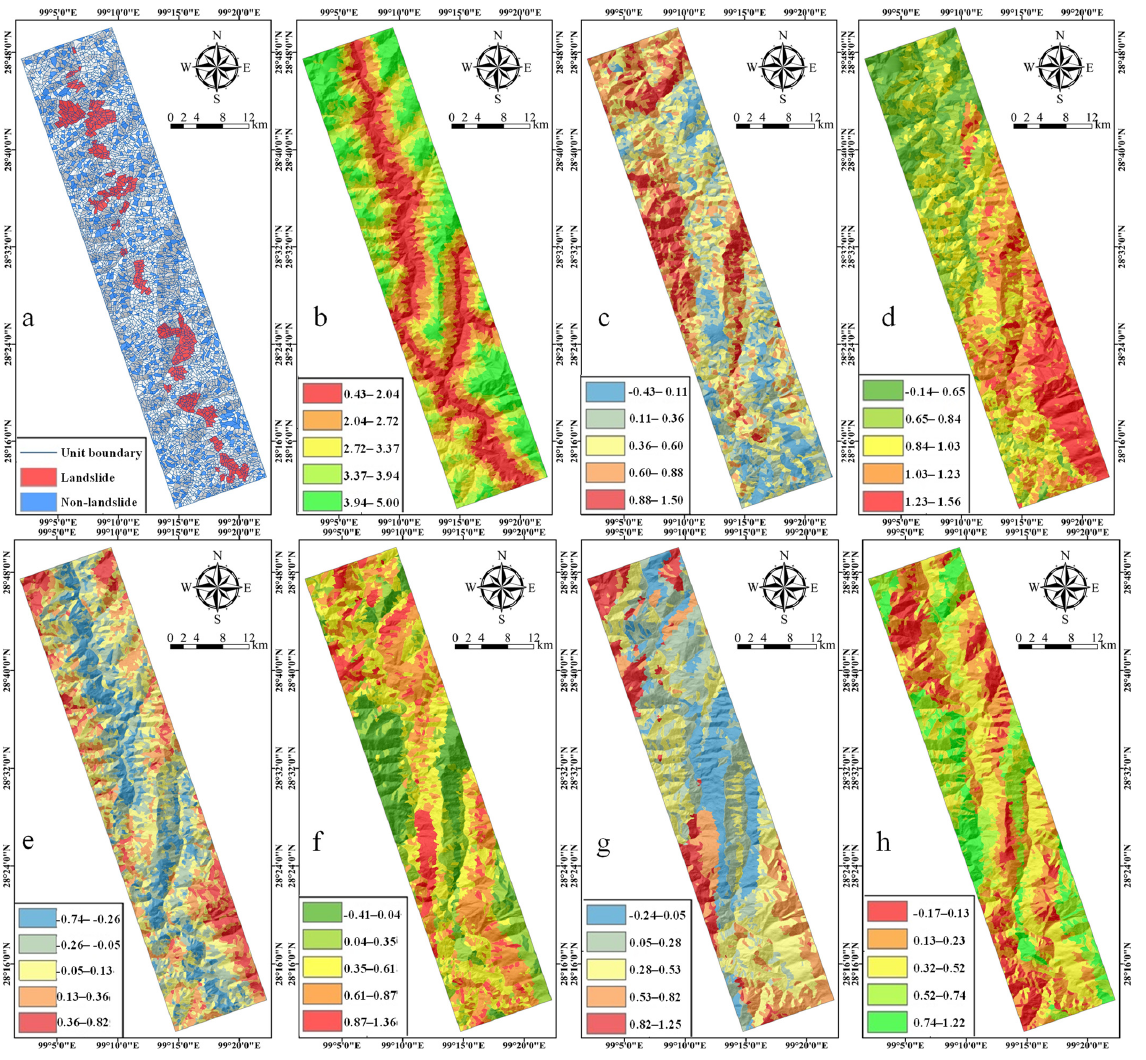
Figure 9. The results of the slope unit division and principal component extraction. ( a ) Slope unit division result; ( b ) principal component 1; ( c ) principal component 2; ( d ) principal component 3; ( e ) principal component 4; ( f ) principal component 5; ( g ) principal component 6; and ( h ) principal component 7.